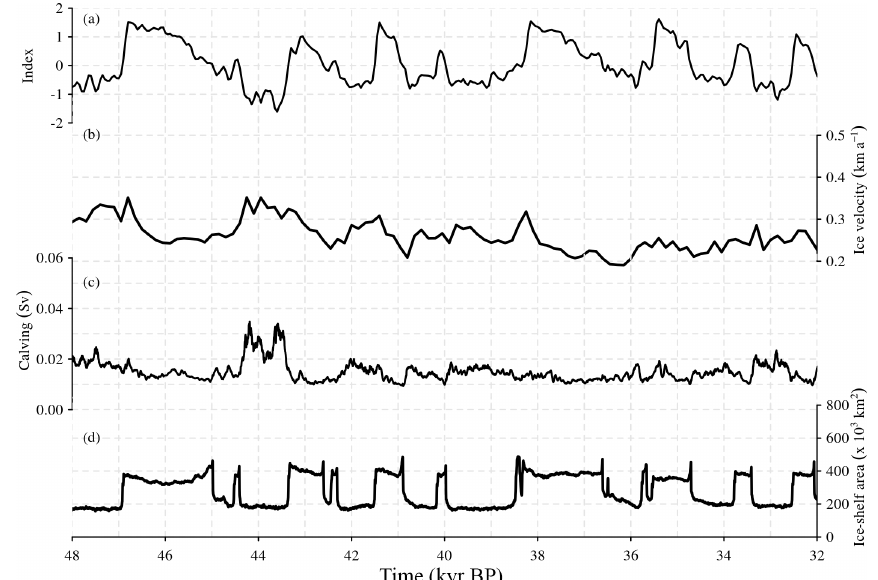
Figure 10. MIS 3 period. Temporal component of the millennial-scale climatic forcing ( β (cid:63) index), ice velocities in the Bjørnøyrenna Basin (calculated as mean values over the entire basin in kilometers per annum), calving rate (Sv) and ice-shelf area (10 3 km 2 ) in the OCN sub simulation.